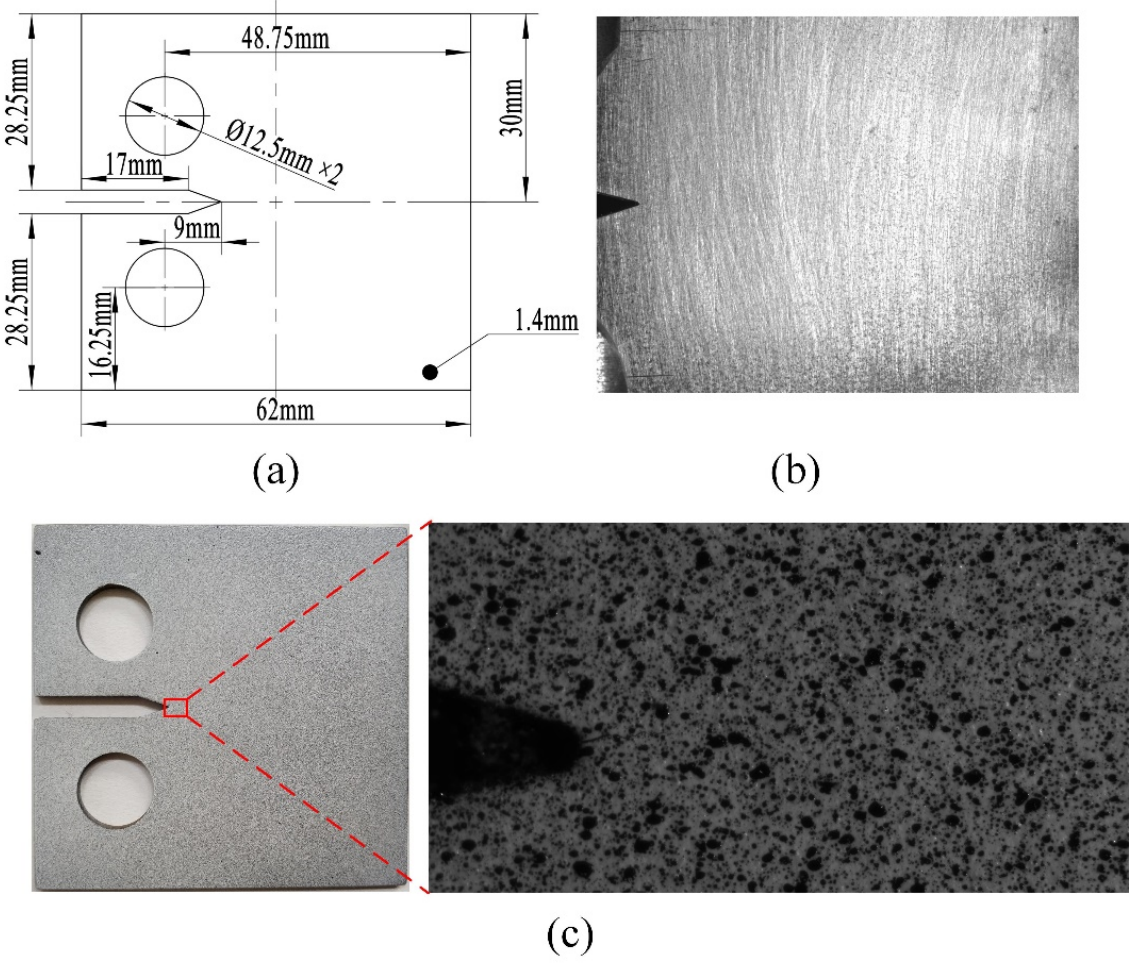
Figure 2. CT specimen information: ( a ) Geometric parameters of the CT specimen; ( b ) global crack image of the CT specimen; ( c ) digital speckle image of the CT specimen.